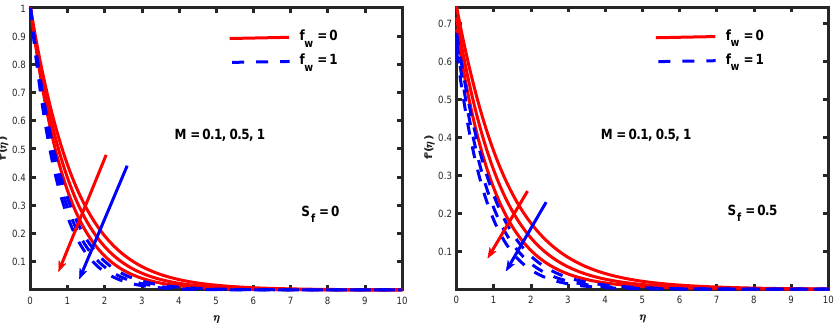
Figure 2. Influence of magnetic and suction/injection parameter on velocity. It is clear from the Figure 3, with the increasing values of material parameter K , an